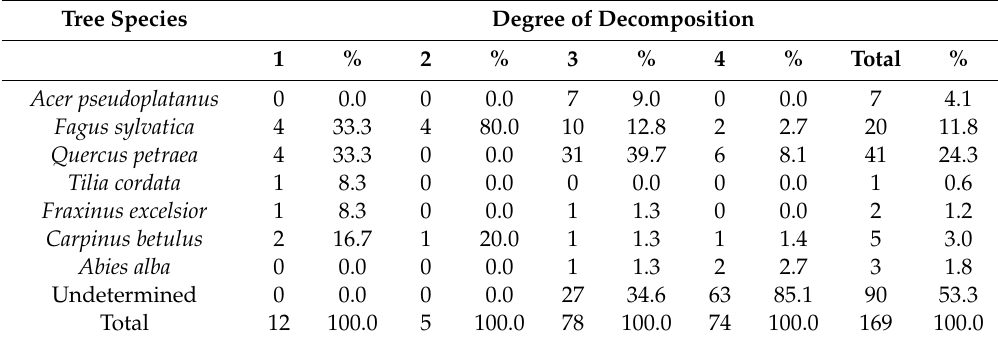
Table 2. Species composition of gapmakers according to degree of decomposition.